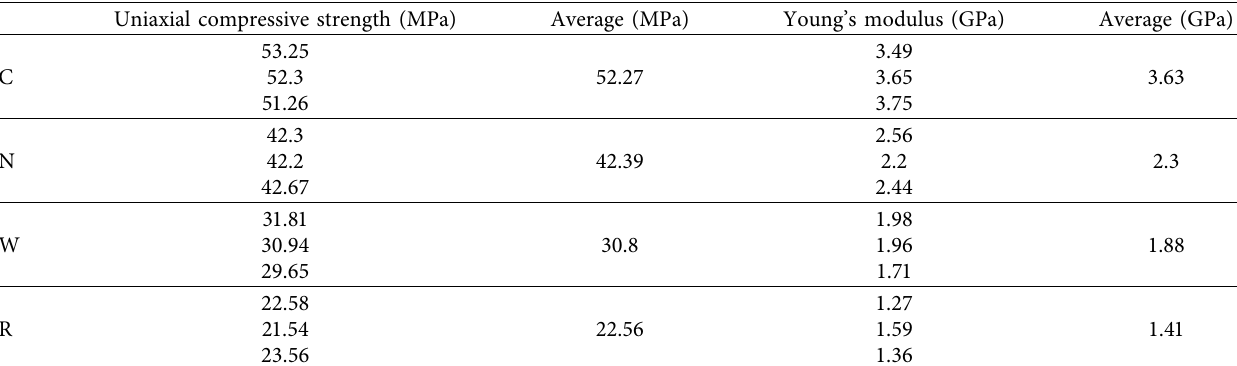
Table 3: Uniaxial compressive strength and Young’s